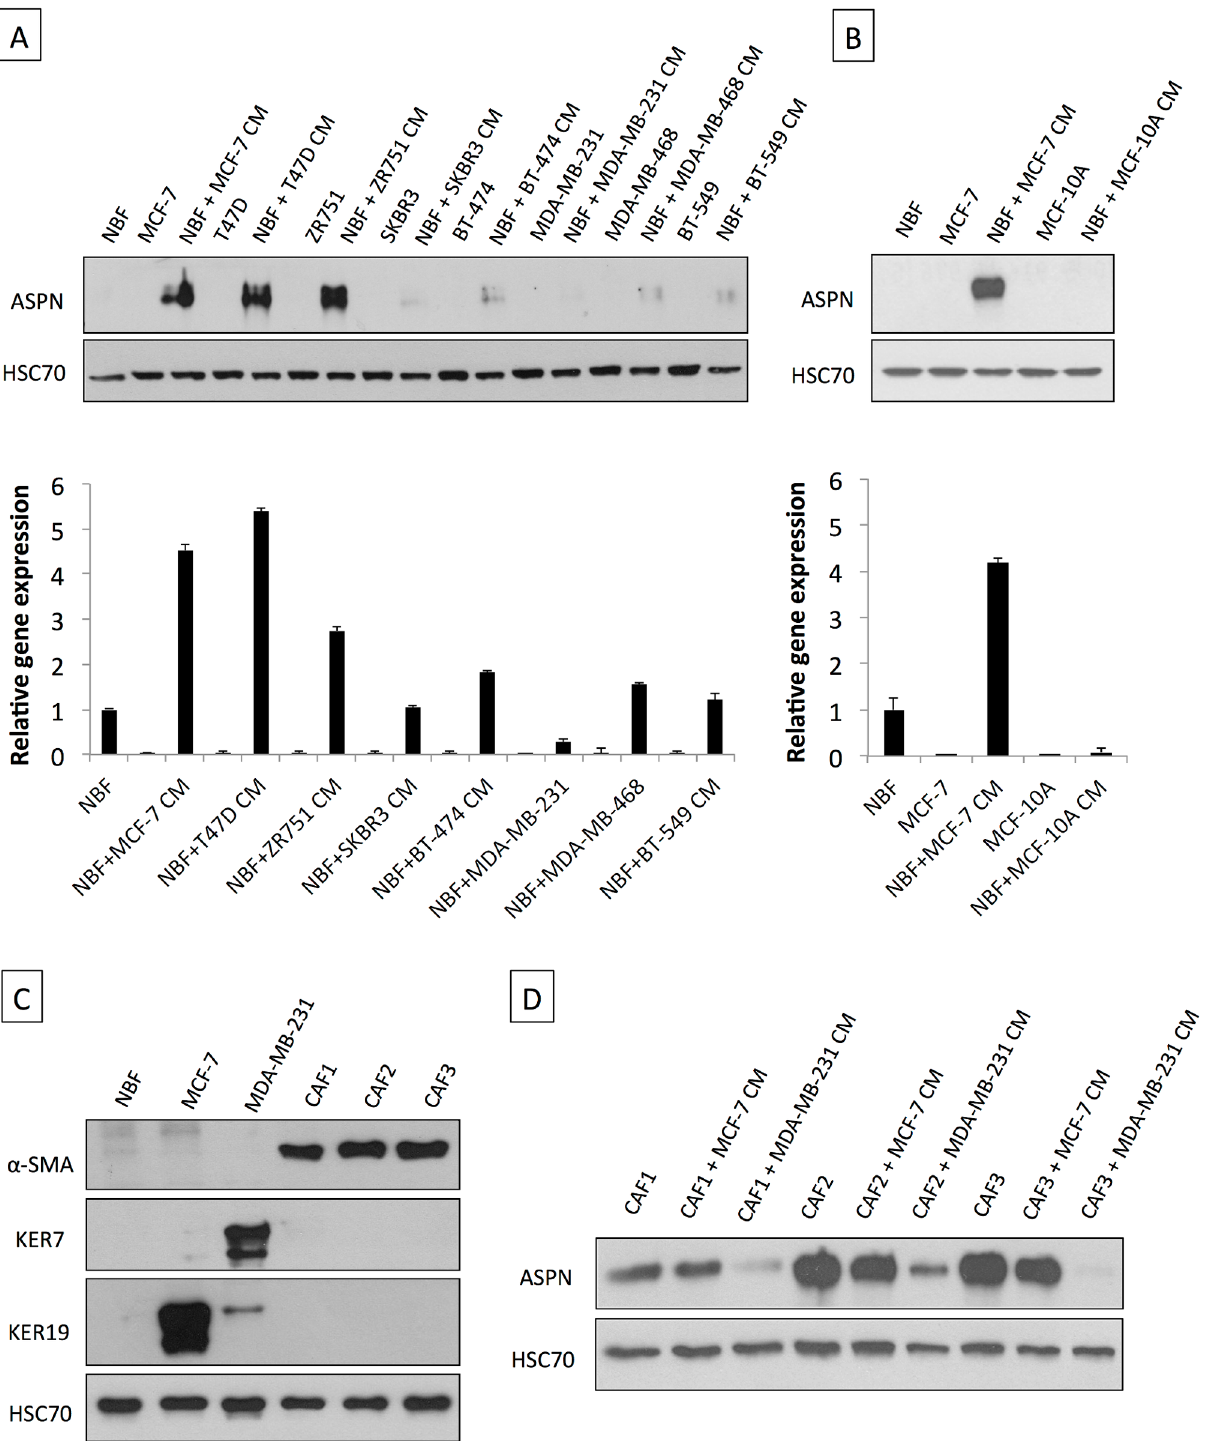
Fig 2. Asporin is produced by breast fibroblasts in response to conditioned medium from breast cancer cells. (A) Western blot of total cell extracts (upper panel) and qRT-PCR analysis for asporin expression (lower panel) in breast cancer cell lines and NBFs incubated for 48 h with CM collected from a panel of breast cancer cells. (B) Western blot of total cell extracts (upper panel) and qRT-PCR analysis of asporin expression (lower panel) in non-cancerous epithelial breast cell line MCF-10A cells and NBFs incubated for 48 h with CM collected from MCF-10A. Fibroblasts treated with MCF-7 CM were used as the positive control for asporin expression induction. (C) Validation of NBFs and CAFs isolated from patient material. MCF-7 and MDA-MB-231 cells were used